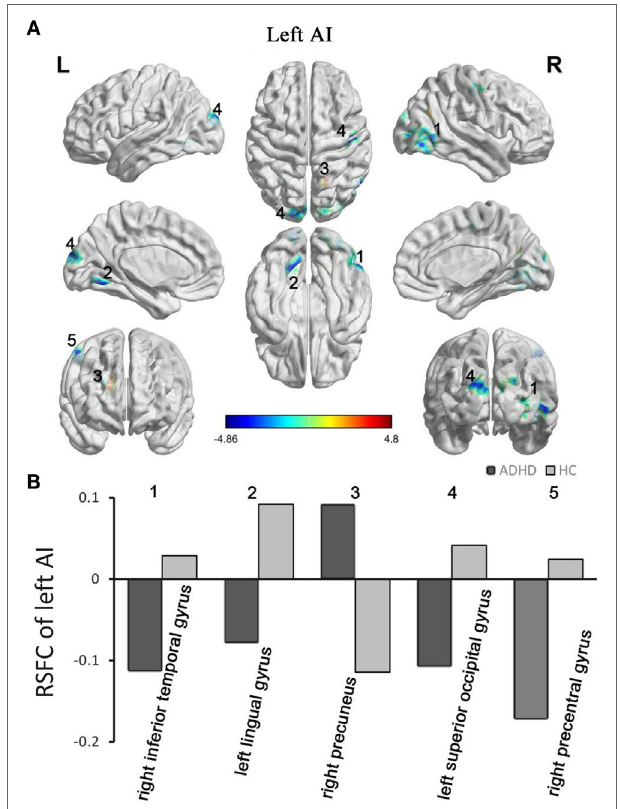
FigUre 2 | Group differences in RSFC of the left AI. Yellow color (ADHD > HC) indicates an increased functional connectivity with the insular subregions in the ADHD group, and blue color (ADHD < HC) indicates a decreased functional connectivity. (a) The clusters show significant differences in the RSFC of the left AI between the two groups. (B) Mean functional connectivity z -scores in clusters showing significant differences in the RSFC between the ADHD and HC groups. Numbers 1–5 marked in (a) refer to the brain regions in (B) . RSFC, resting-state functional connectivity; AI, anterior insula; HC, healthy control; ADHD, attention deficit/hyperactivity